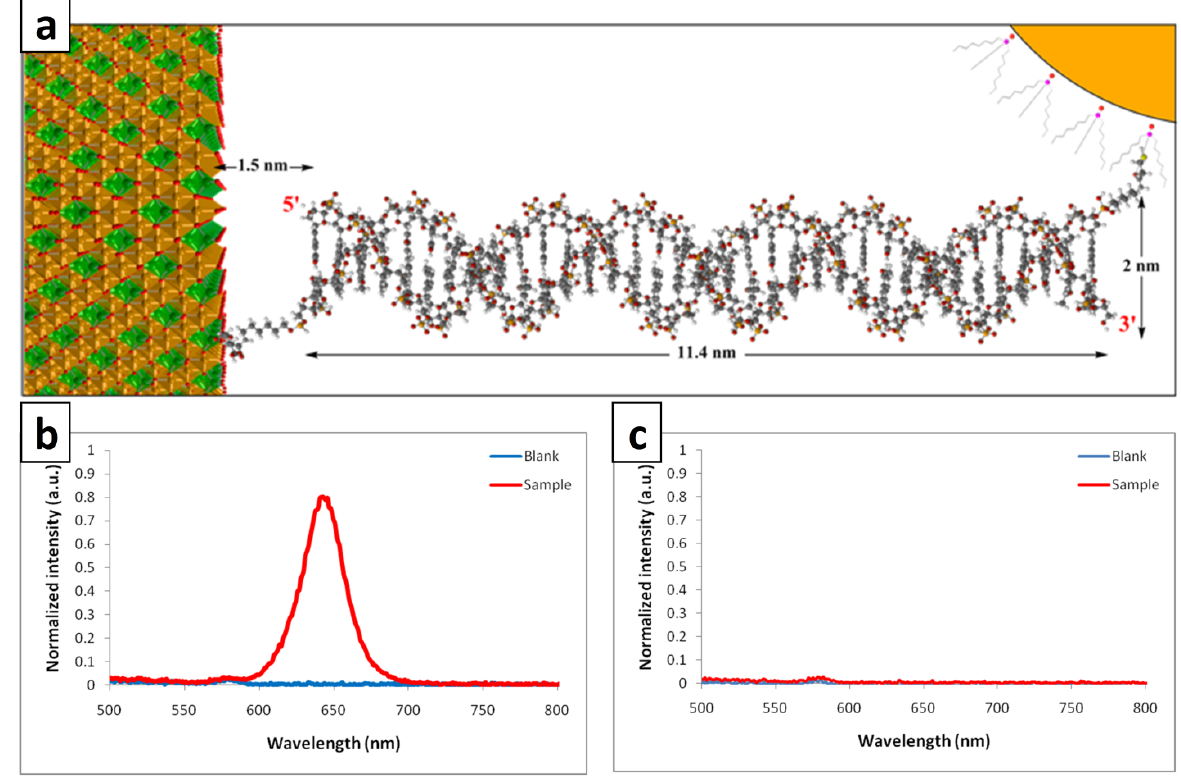
spectra. ( a ) molecular model of the designed structure at the presence of tDNA ( b )